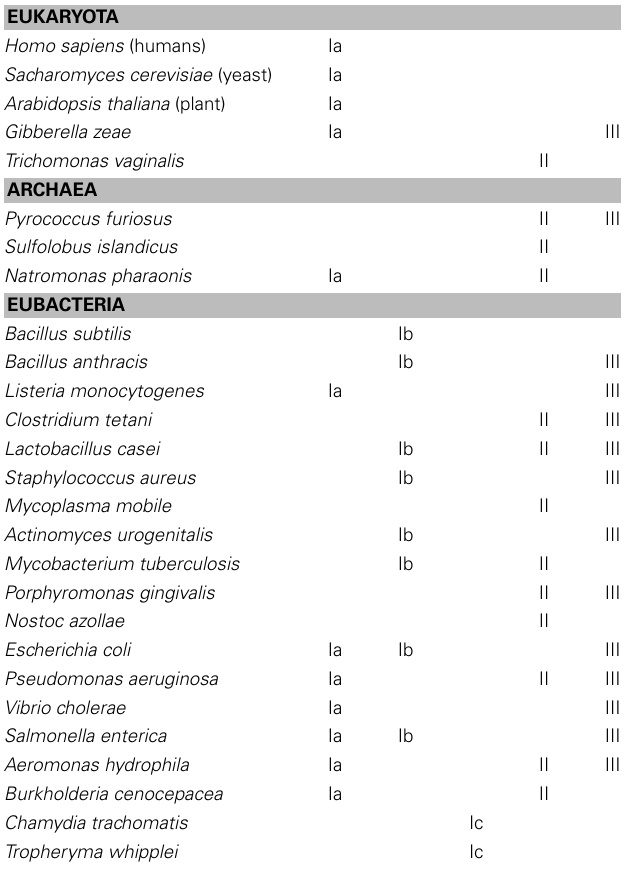
Table 2 | The distribution of RNR in the three domains of